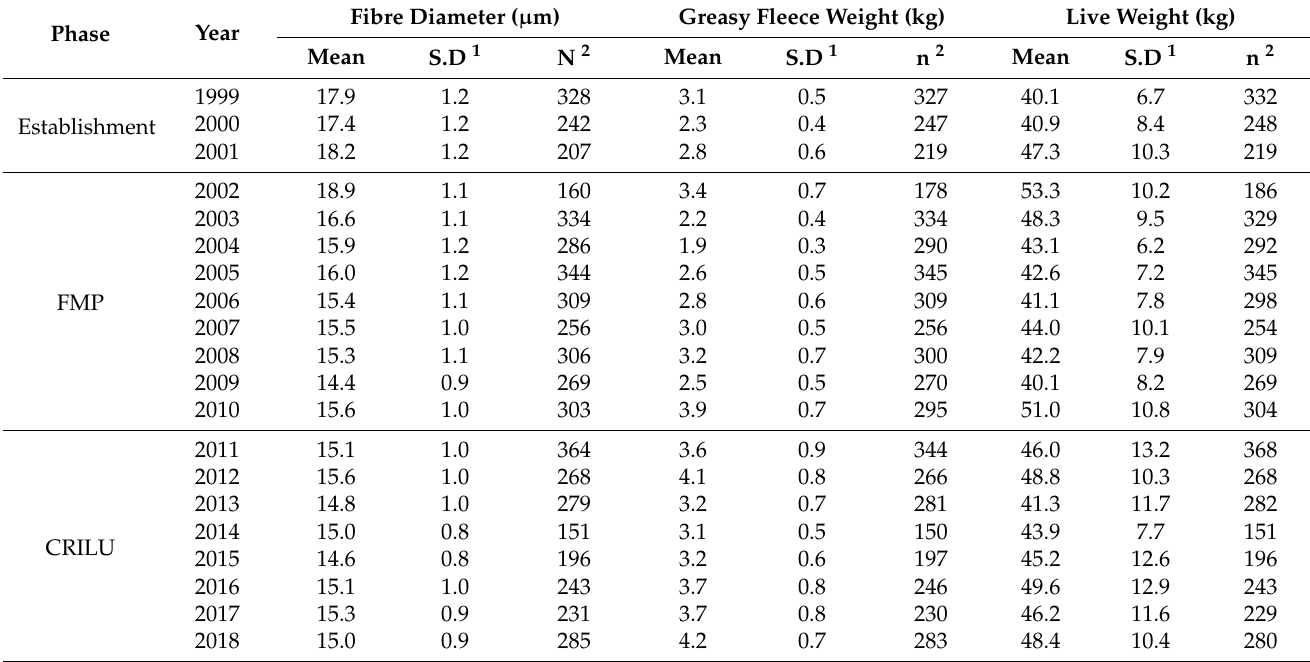
Table 4. Annual mean, standard deviation and number of records of fiber diameter, greasy fleece weight at shearing (298 to 432 days of age), and live weight post-shearing (321 to 438 days of age) for the combined one-year-old female and male lambs